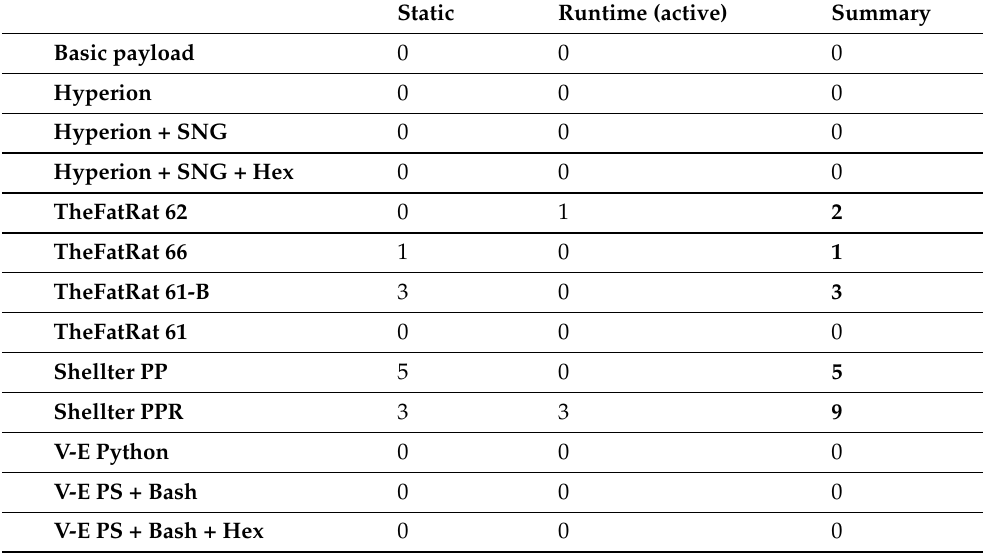
Table 5. Summary results for evasion tools and their combinations.